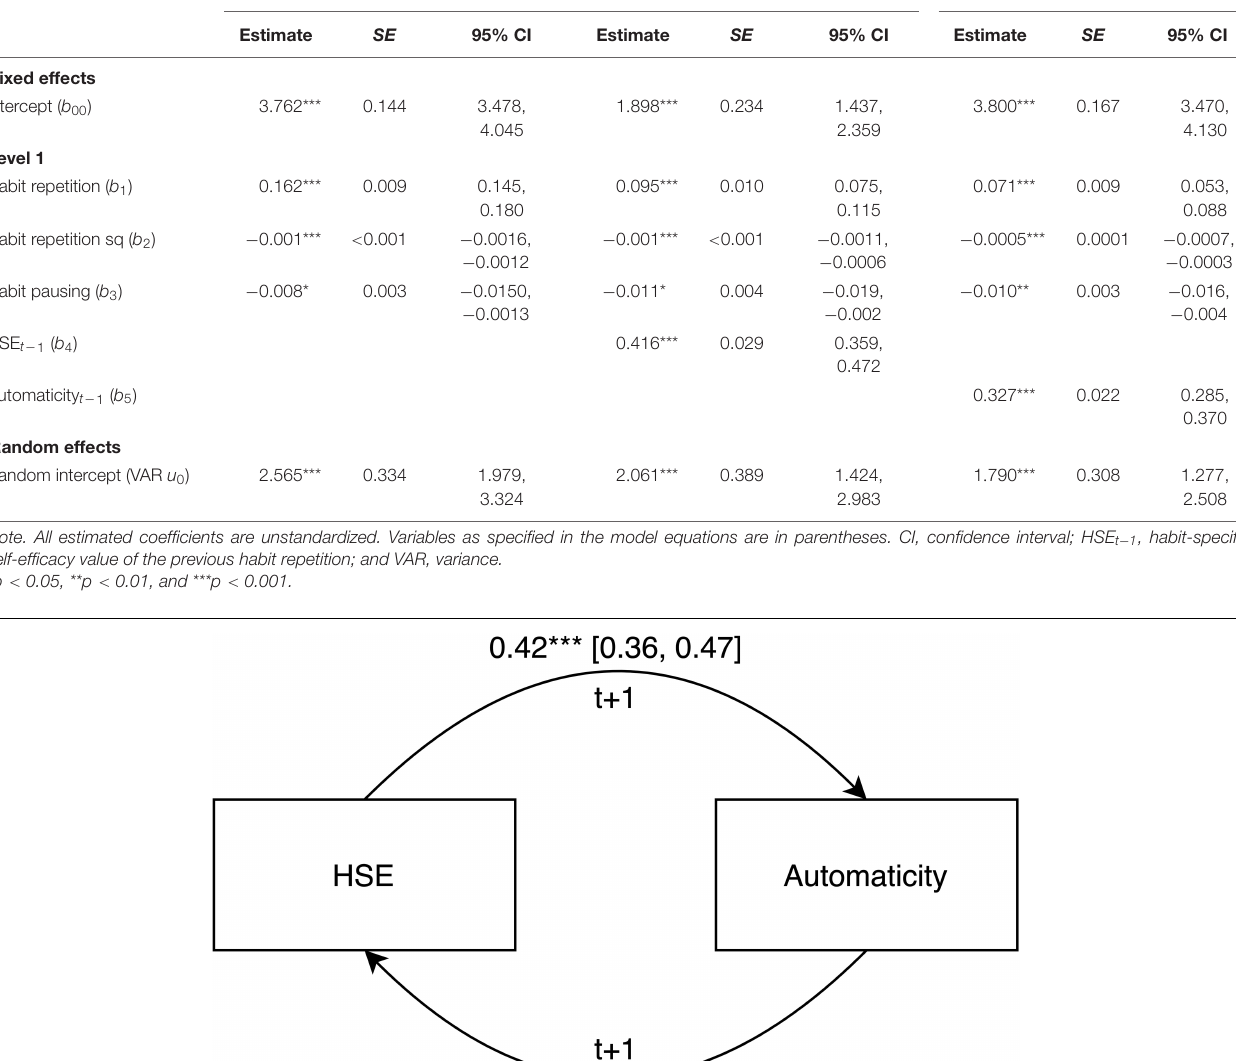
habit repetitions (Level-1-effect) and HSE averaged over habit repetitions could predict average MI